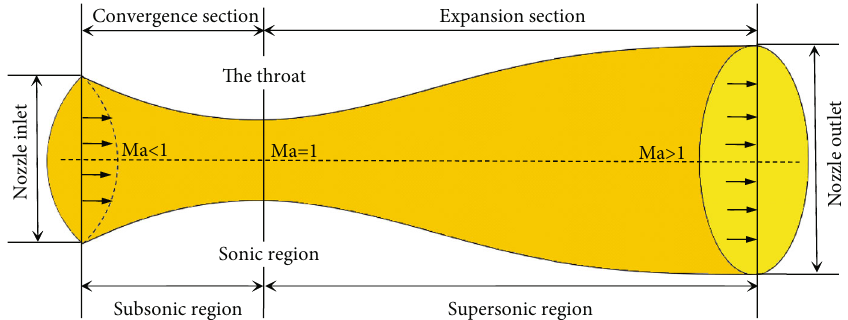
Figure 2: Schematic diagram of a scaled nozzle structure.